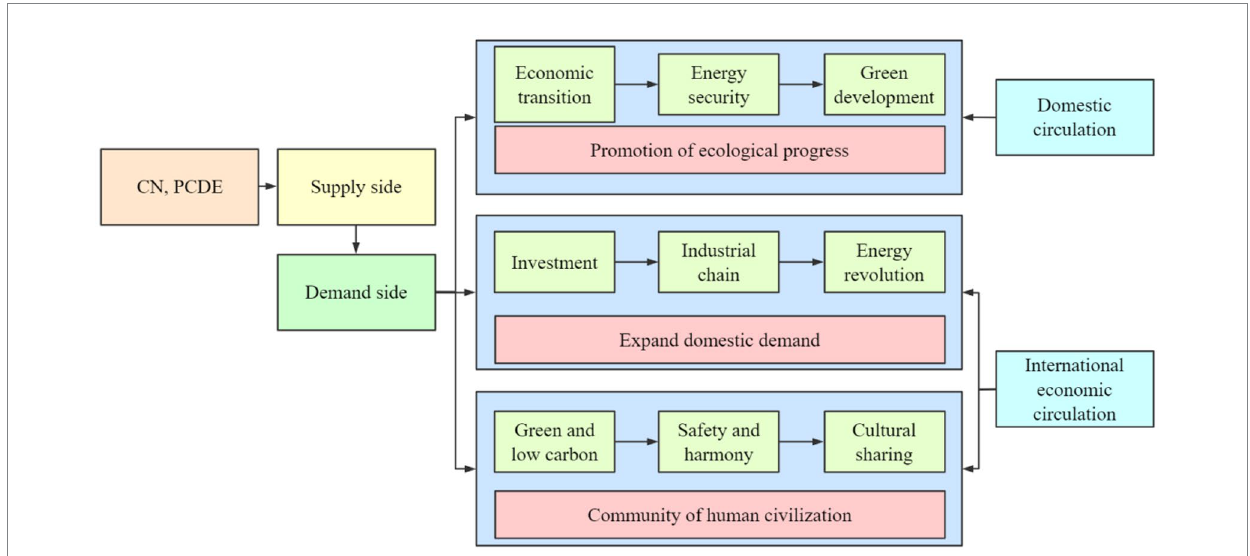
FIGURE 1 Peak carbon dioxide emissions (PCDE) and CN empower the internal logic of high-quality